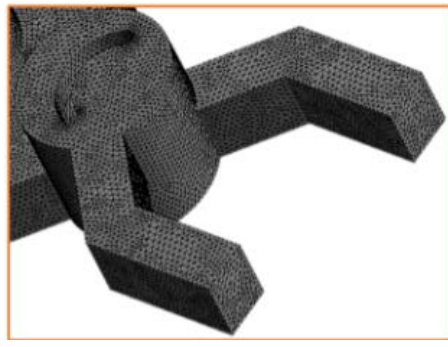
Figure 3. Structure of the generated mesh grid.